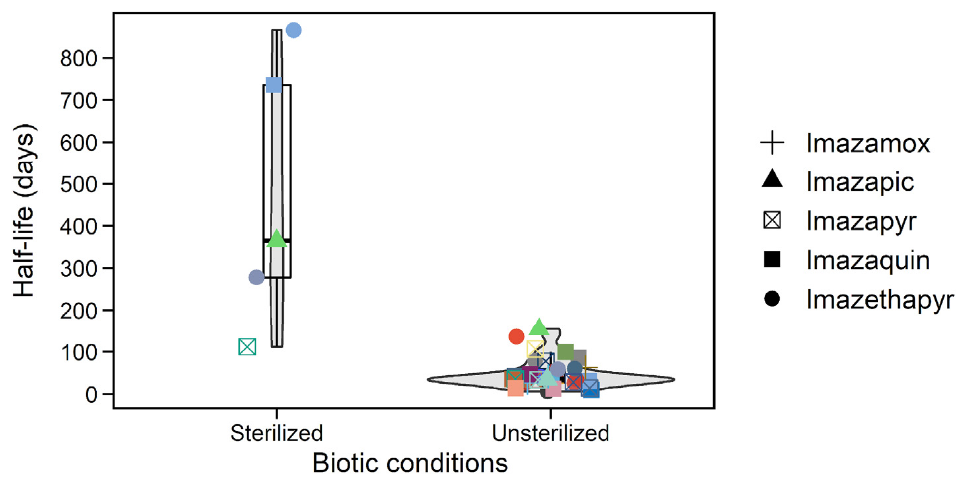
Figure 4. Half-life of imidazolinones in sterile and unsterilized